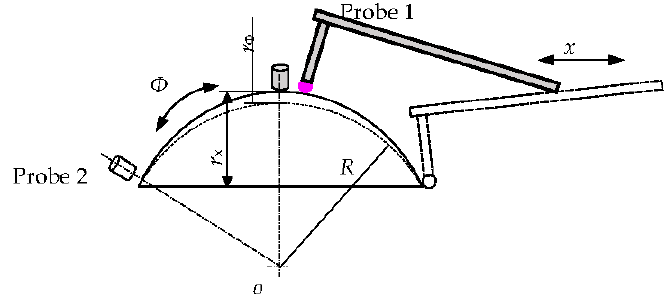
Figure 1. Different ways of using the probe between spherical coordinates and orthogonal coordinates.